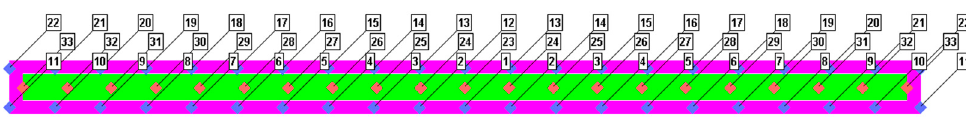
Figure 6. The distribution of Gauss points in ERA.